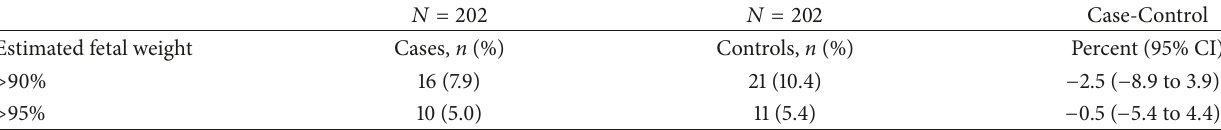
Table 4: Number and proportion of macrosomic neonates at two diagnosis thresholds in case and control groups. 𝑁 = 202 𝑁 = 202 Case-Control Estimated fetal weight Cases, n (%) Controls, n